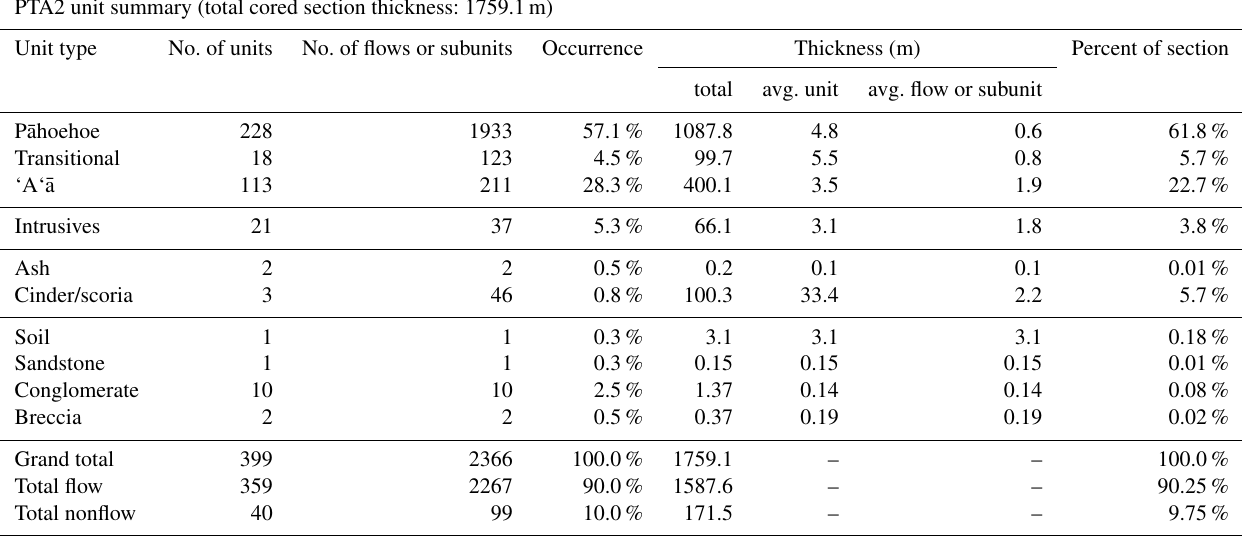
Table 1. Summary data of lithologies (facies) intersected in hole PTA2. PTA2 unit summary (total cored section thickness: